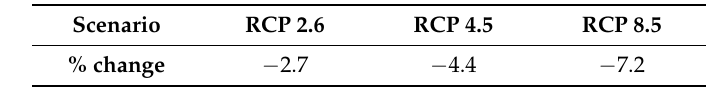
Table 2. Expected change in number of failures/failure rates within 2070 due to temperature increase. The change is given in % compared to historical failure